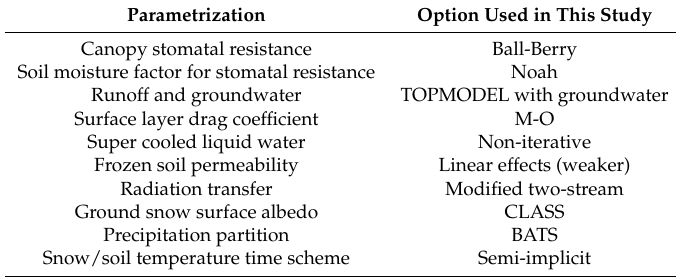
Table 2. Options selected for key land surface processes parameterizations in